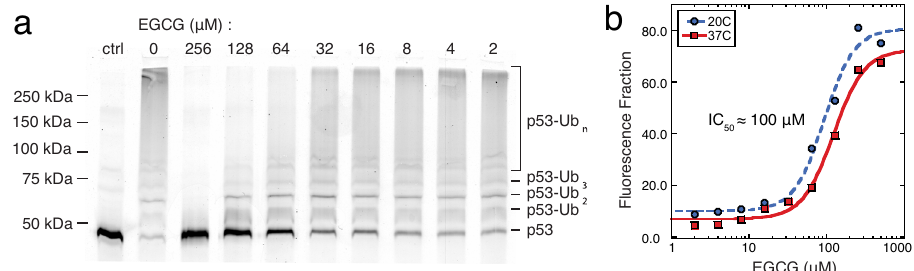
Fig. 6 EGCG inhibits the MDM2-catalyzed ubiquitination of p53 in vitro. a In vitro ubiquitination of fl uorescein-tagged p53 was carried out in the presence of up to 0.25 mM EGCG at 20 °C. The results were visualized by fl uorescence SDS – PAGE. b Plotting the fl uorescence fraction of residual unmodi fi ed p53 as a function of EGCG concentration and fi tting to a four-parameter sigmoid indicates that EGCG has an IC 50 of ~100 μΜ for the MDM2- catalyzed ubiquitination of